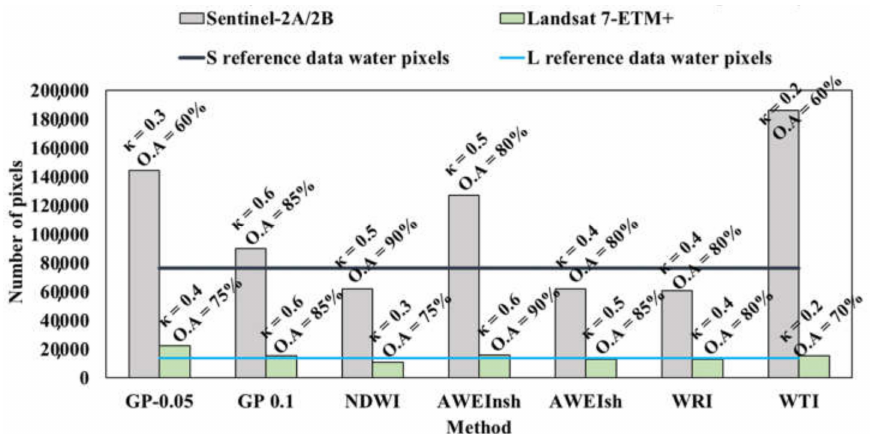
Figure 2. Accumulated number of water pixels estimated by the different methods tested, for the entire dataset using Sentinel-2A/2B (S) and Landsat-7 ETM+ (L) imagery. Black and blue lines indicate the water pixel number of the reference data at the 10 m (S) and 30 m (L) spatial resolution, respectively. k refers to the kappa coefficient value and O.A to the overall accuracy